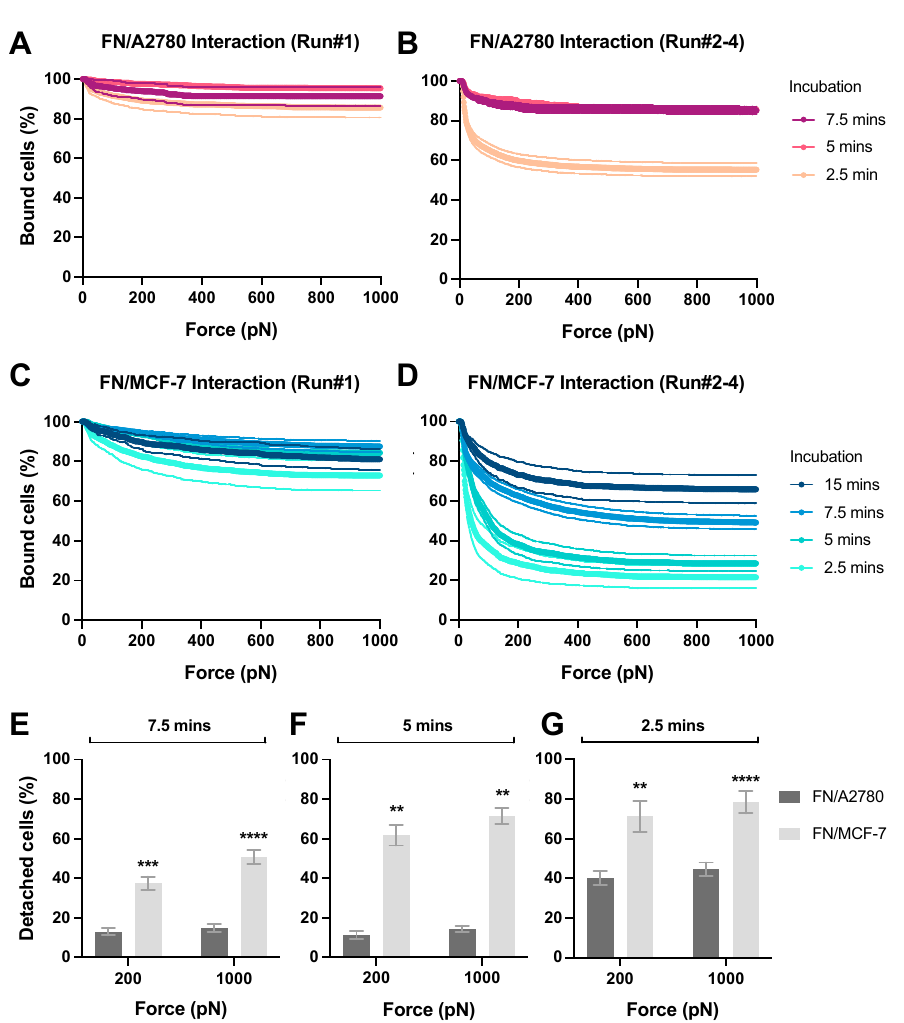
Figure 6. Avidity measurement of ECM protein layer interacting with tumor cells. FN protein was coated on the flow chamber surface at 50 µ g/mL as the protein monolayer (‘Target’). A2780 or MCF-7 cells pre-stained with the CellTrace™ Far Red dye were flushed into the flow chamber as the ‘Effectors’ and incubated with the FN monolayer for 2.5 to 15 min before the acoustic force was applied. The percentage of effector cells bound to FN under the force from 0 to 1000 pN was measured and analyzed to indicate the avidity. The data from the first runs of each chips using ( A ) A2780